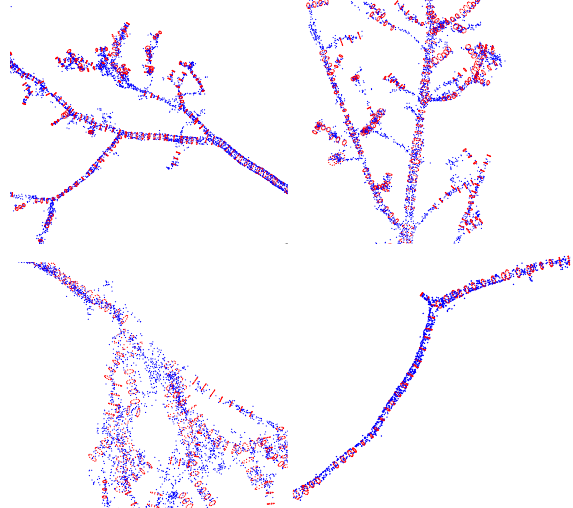
Figure 9: Cylinder fitting for branches. The upper branches are from deciduous tree and the bottom branches are from coniferous tree. The point clouds (blue points) are thinned out.